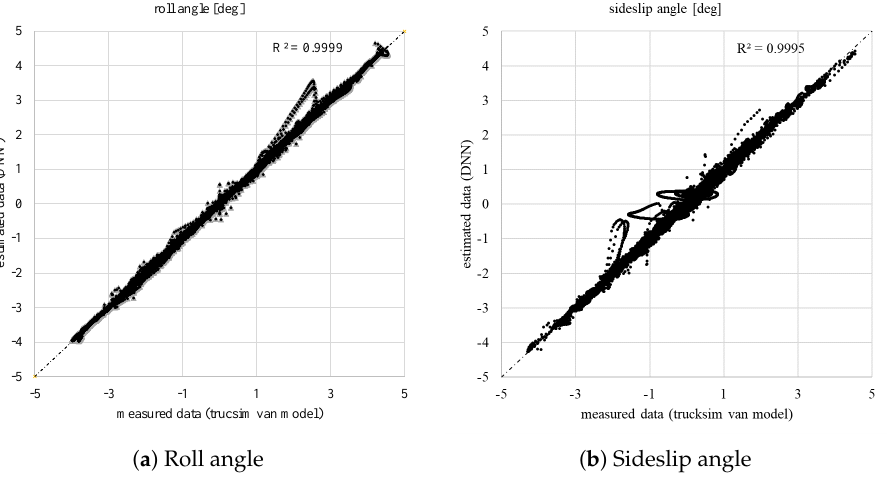
Figure 9. Comparison between measured data from the TruckSim R (cid:13) van model and the estimated data from DNN.